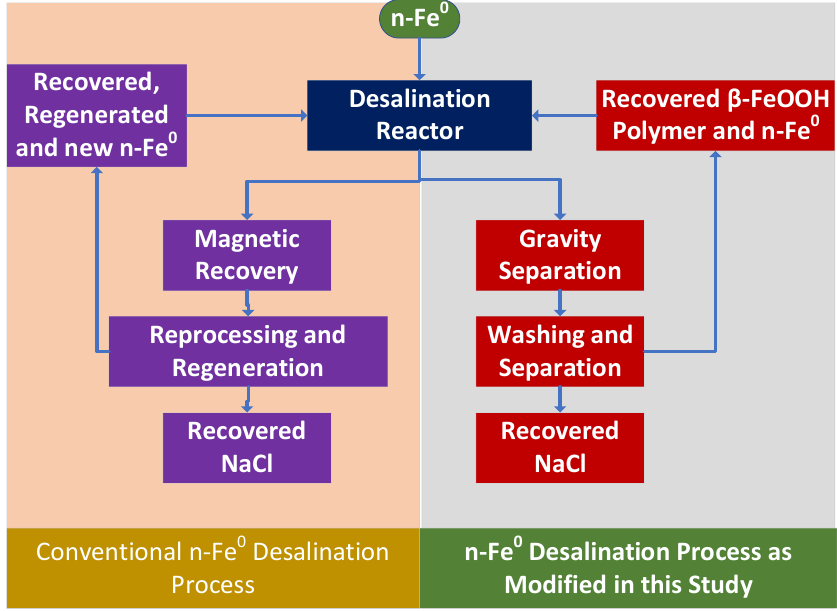
Figure 4. Summary of the desalination of groundwater using n-Fe 0 to produce partially desalinated irrigation water.